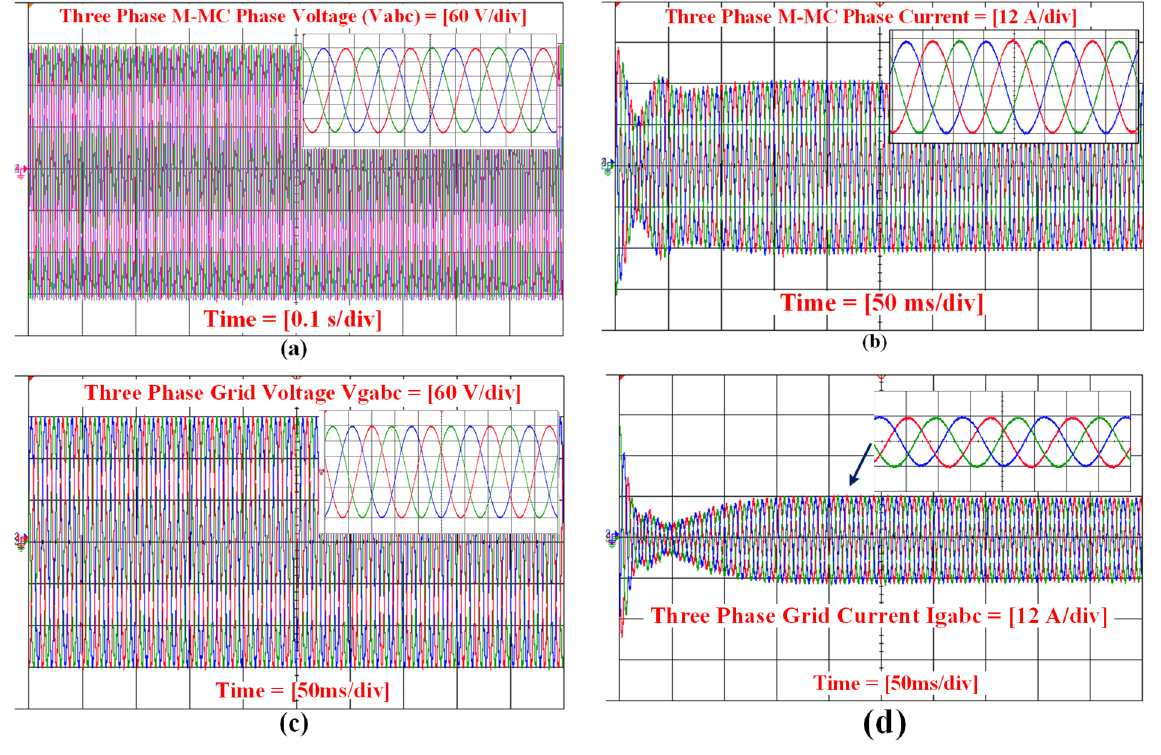
Figure 18. ( a ) Output voltage of three-phase MMC, ( b ) output current of three-phase MMC, ( c ) three-phase grid output voltage, and ( d ) three-phase grid current.